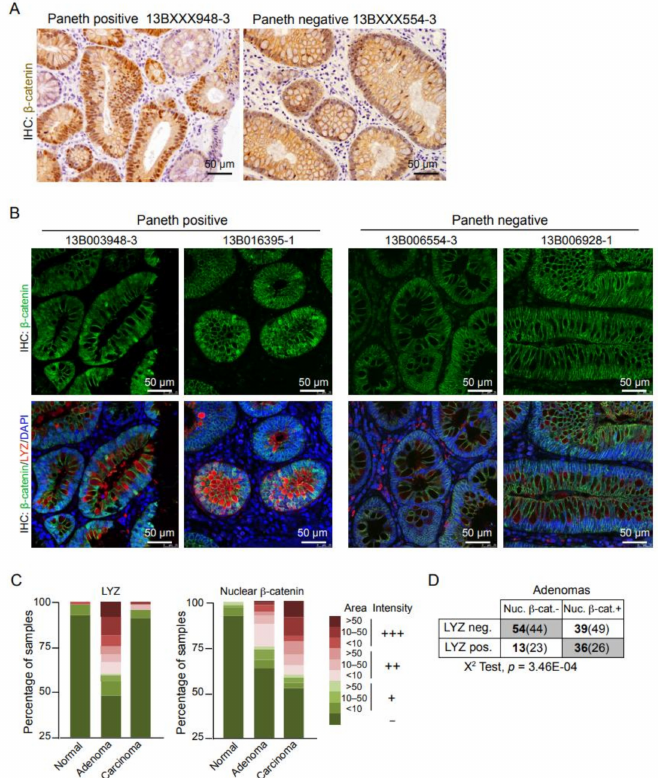
Figure 2. Wnt/ β -catenin activity is increased in Paneth cell-enriched adenoma areas. ( A ) Immunohis- tochemical (IHC) analysis with anti- β -catenin antibody. Representative images of Paneth cell-positive and -negative samples are shown. ( B ) Double immunofluorescence (IF) analysis of β -catenin and LYZ in the indicated samples. DAPI was use for nuclei staining. ( C ) Quantification of the intensity of staining and area of the tissue (normal of tumoral) that was considered positive for the indicated markers. ( D ) Correlation analysis of the presence of nuclear β -catenin and LYZ positivity in the adenoma samples. The actual number of samples is shown in bold and the expected numbers from a random distribution are in the parentheses. A chi-square test was used to determine possible dependence between the analyzed